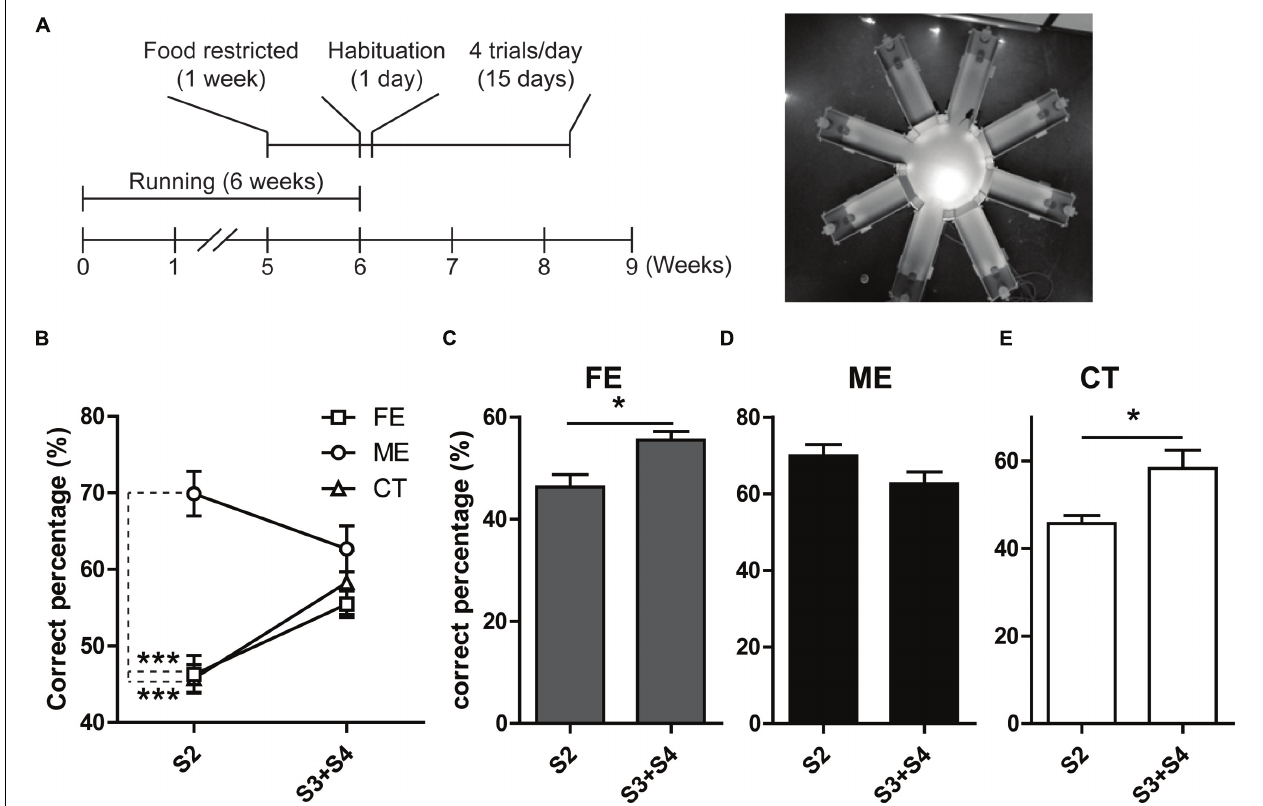
FIGURE 4 | Analysis of behavior in the RAM. (A) Left, timeline of the RAM test. Right, photograph of the RAM arena. (B) ME but not FE increases the percent of correct choices at S2. Neither of them has effect on the percent of correct choices at S3 + S4 separations. Two-way ANOVA, F 2 , 18 = 19.57, P < 0.0001; post hoc test: ME vs. CT: ∗∗∗ P < 0.001; ME vs. FE: ∗∗∗ P < 0.001; FE vs. CT: P > 0.05; n = 7 in each group. (C) The FE group shows a higher percent of correct choices at S3 + S4 than at S2. Paired t -test, ∗ P < 0.05. (D) The ME group shows a percent of correct choices at S2 similar to that at S3 + S4. Paired t -test, P > 0.05. (E)